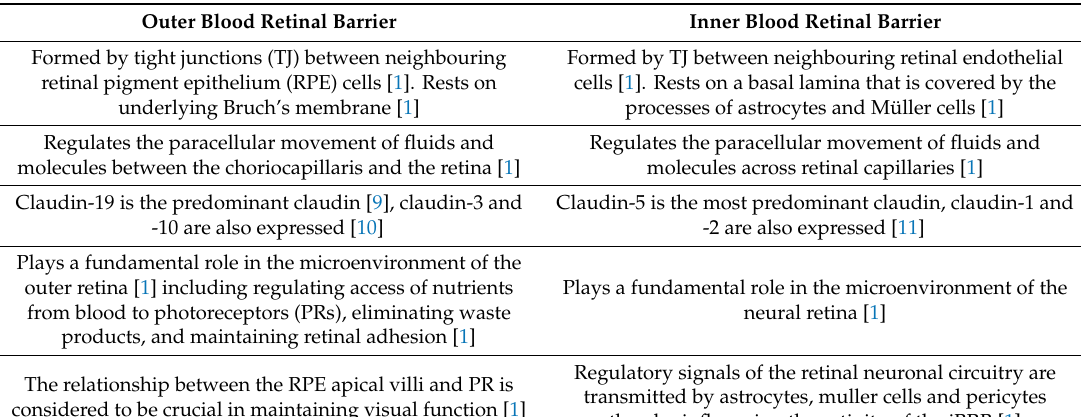
Table 1. A summary of the key di ff erences between the outer blood retina barrier (oBRB) and inner blood retinal barrier